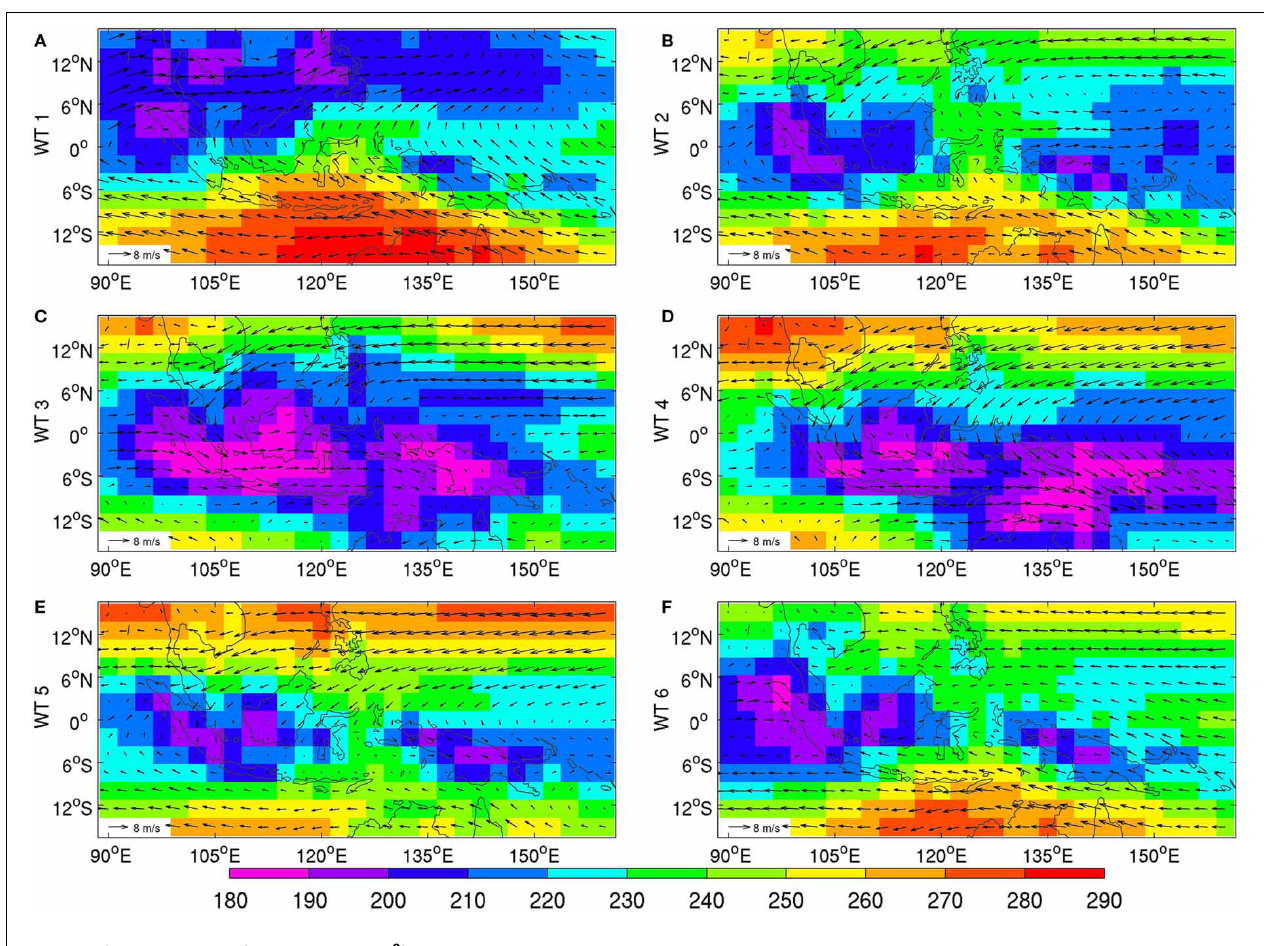
FIGURE 4 | Mean raw OLR (shadings in Wm − 2 ) and 850 hPa winds (vectors) for (A) WT 1, (B) WT 2, (C) WT 3, (D) WT 4, (E) WT 5, (F) WT 6 defined using k -means clustering of the standardized anomalies of 850